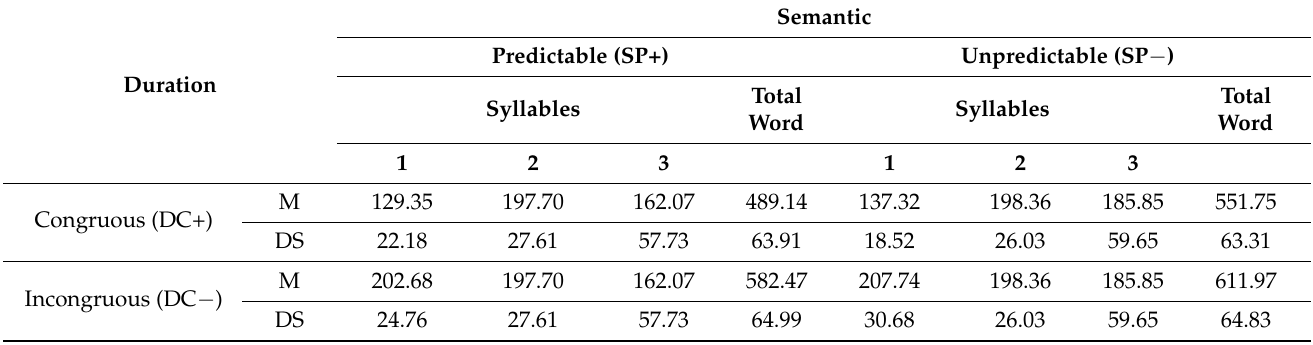
Table 2. Mean duration and SD in ms in each syllable in the last word in the four experimental conditions. Semantic Predictable Duration